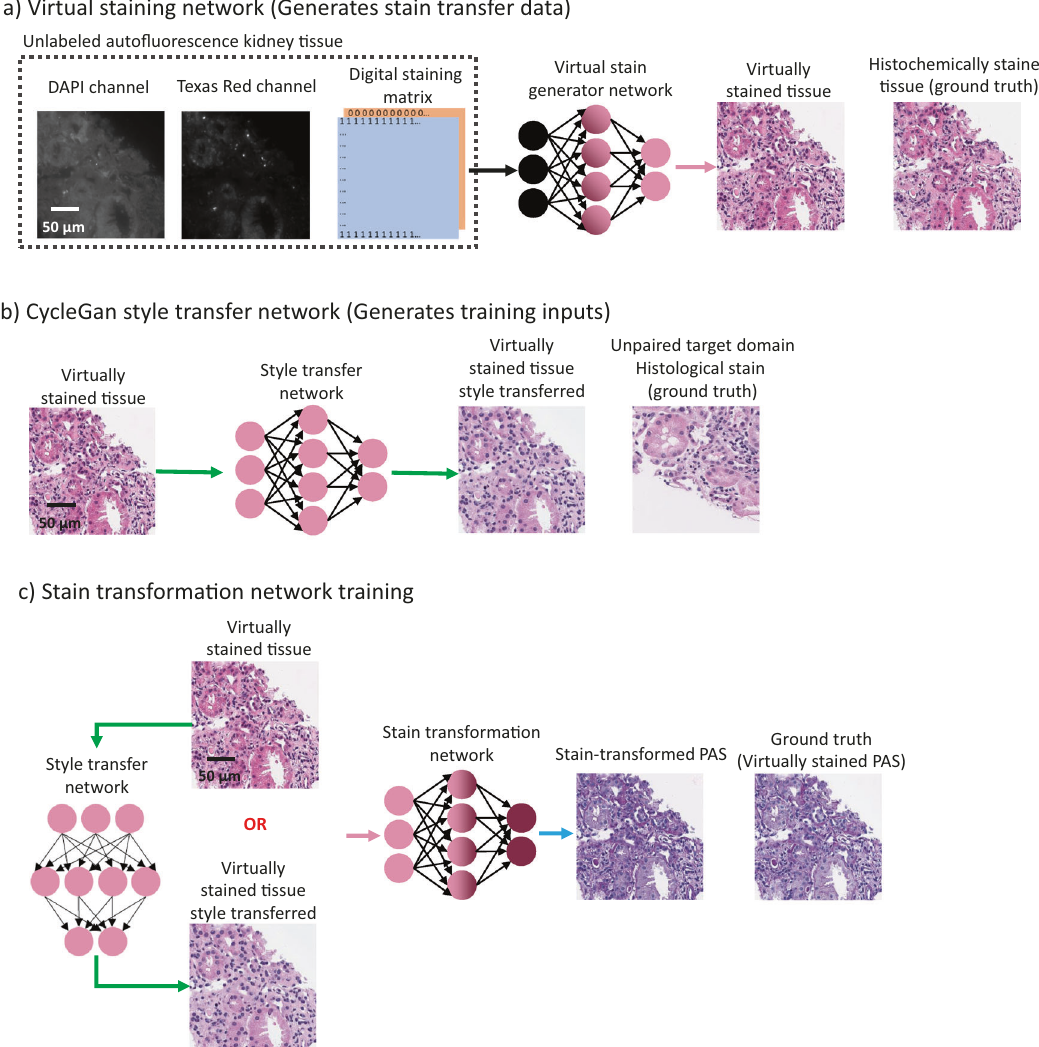
Fig. 2 Deep neural networks used to generate the training data for the stain transformation network. a Virtual staining network (pink arrow) which can generate both the H&E and special stain images. b Style transfer network (green arrow) that is used just to augment the training data. c Scheme used to train the stain transformation network. During its training, the stain transformation network is randomly given, as the input, either the virtually stained H&E tissue, or an image of the same fi eld of view after passing through one of the eight style transfer networks. A perfectly matched virtually stained tissue image with the desired special stain (in this example shown: PAS) is used as the ground truth to train this neural